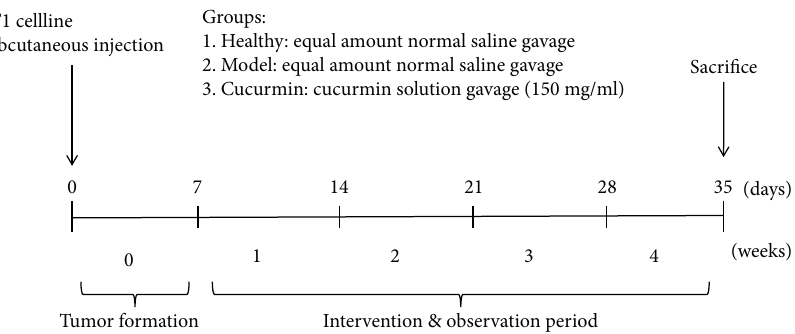
Figure 1: Schematic diagram of the research